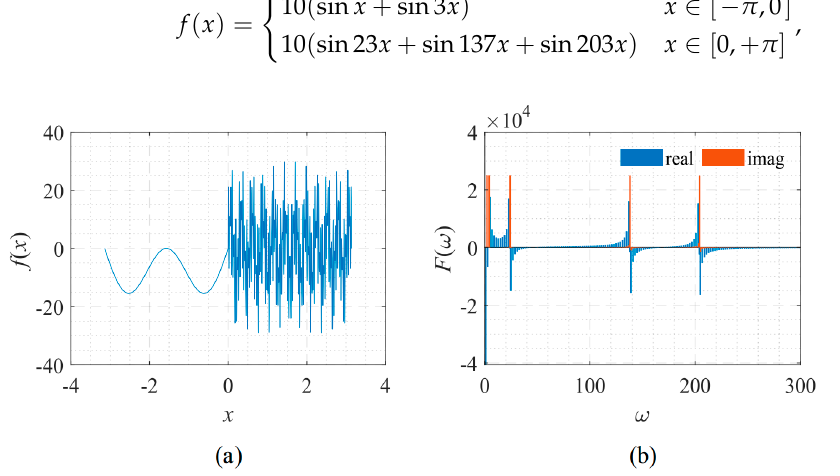
Figure 19. The influence of Δ ω on the convergence process.